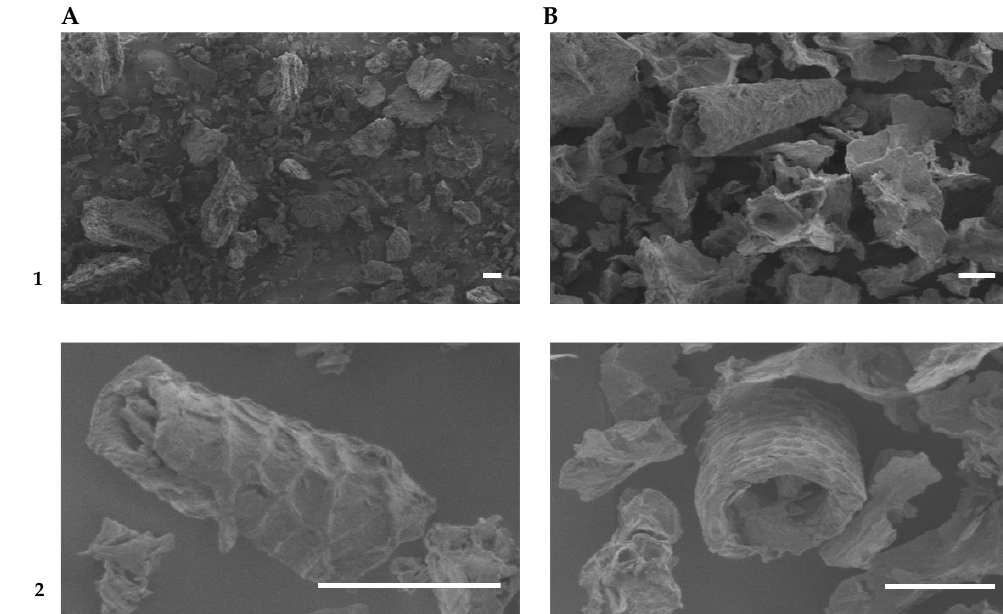
Figure 6. SEM micrographs of samples of apple by-product: control ( A ), HHP-treated at 200 MPa ( B ) (own photos). The white scale bar on micrographs corresponds to 100 μm. Magnification (referred to the 12.67 cm × 8.82 cm raw picture size) was: (a) × 50 (1) , × 500 (2), (b) × 100 (1) , × 300 (2) .